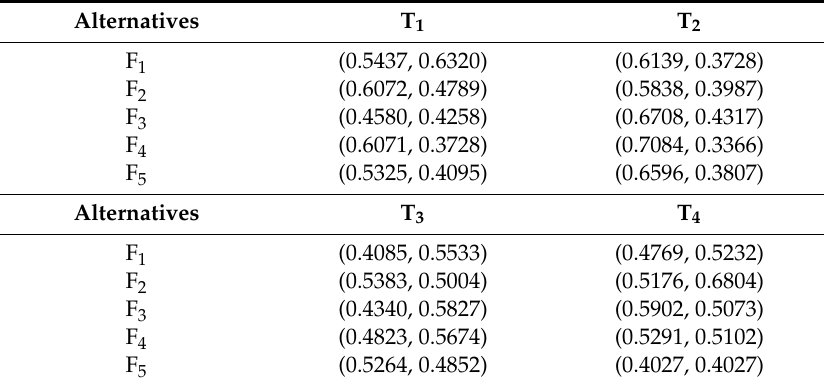
Table 11. Pythagorean fuzzy overall assessing matrix.